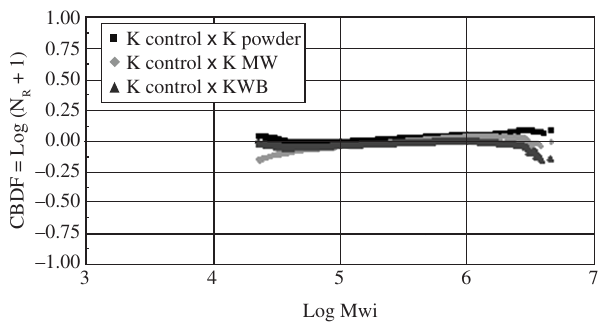
Figure 5. Chain Branching Distribution Function from the comparison of the reference curve (K-control) with the other curves (K powder, K after MW, and K after WB).